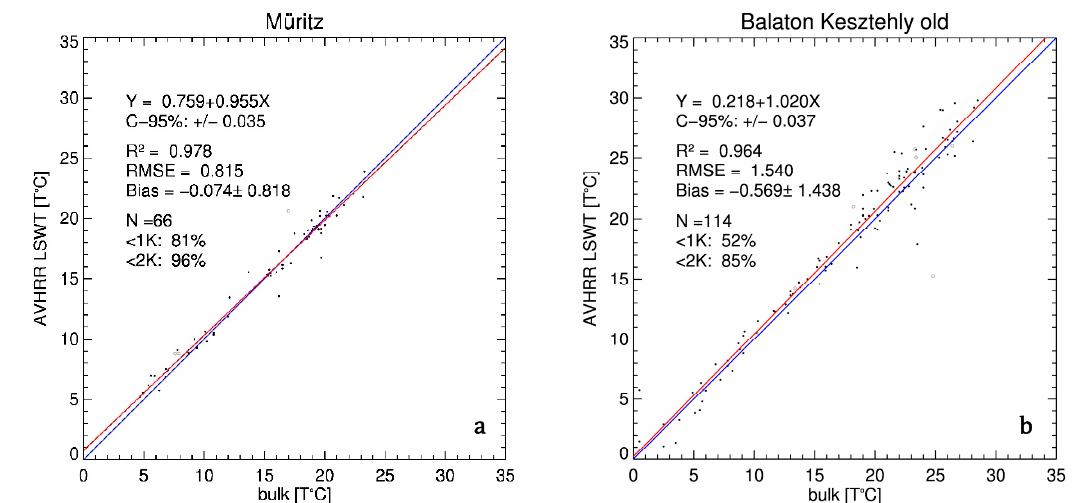
Figure 7. The validation with sporadic instant measurement at Müritz ( a ) and at Lake Balaton ( b ). Both in-situ measurements where manually taken in open waters. The bi-monthly sampling frequency only allows for few matchups per year. Nevertheless, the measurements at Müritz yield the best performance thanks to close temporal matchups and the open waters. At Lake Balaton however, the exact timestamp was unknown (only day). Therefore, 12:00 local time was assumed, which led to less accurate temporal matchups and lower correlation. Remote Sens. 2018 , 10 , x FOR PEER REVIEW